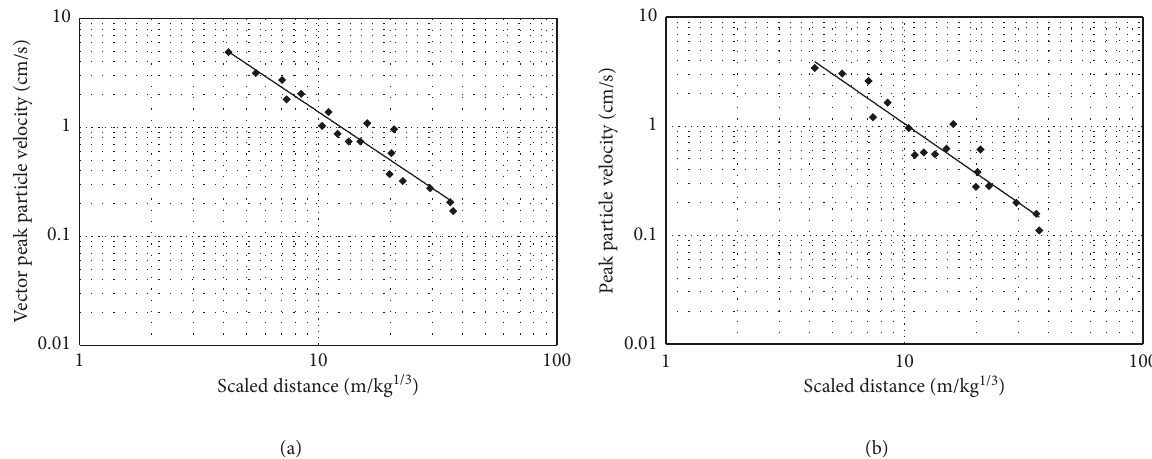
Figure 5: PPV for single-hole blasting versus scaled distance. The largest amplitude of (a) vector summation and (b) the radial component.